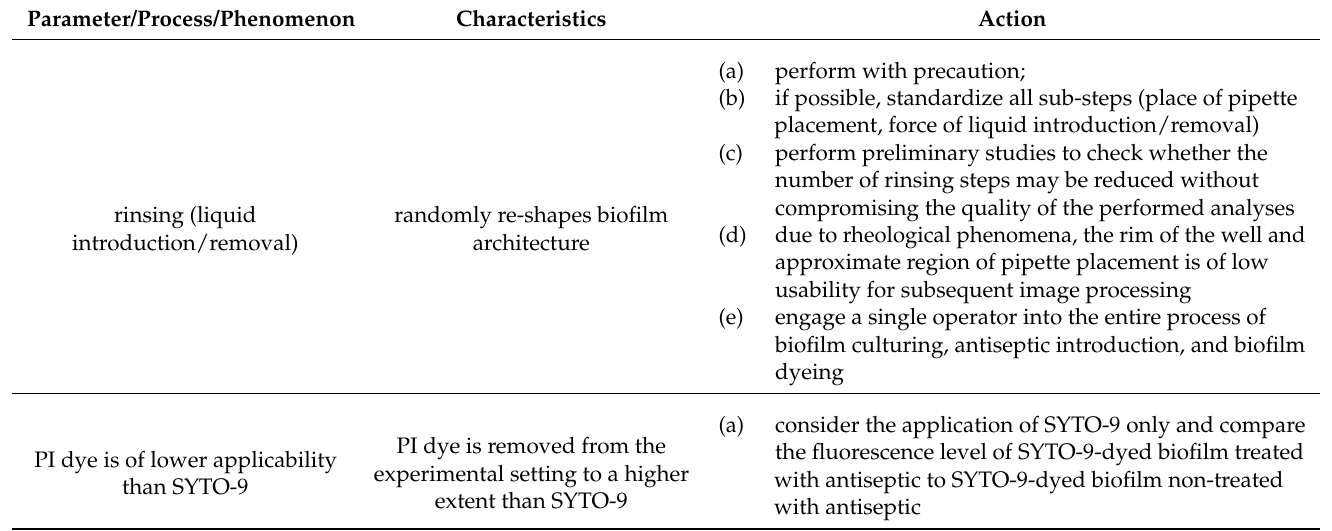
Table 3. Main preparative/process variables associated with the deviation in the obtained results and the suggested,